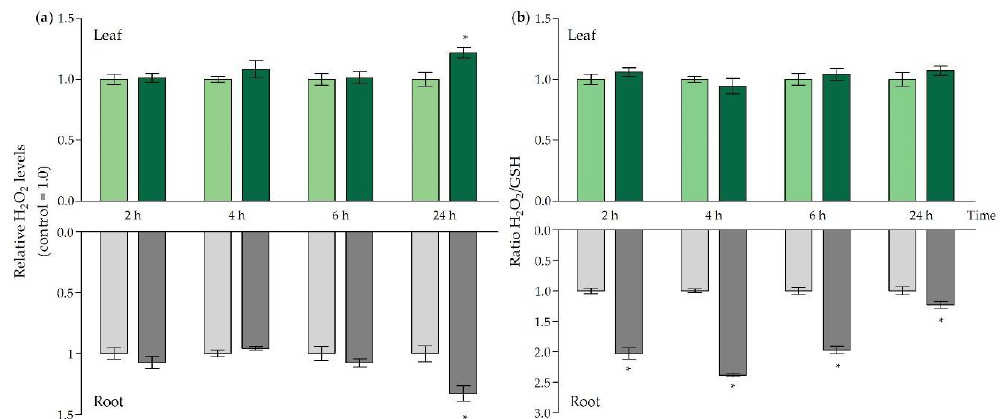
Figure 3. ( a ) Relative hydrogen peroxide (H 2 O 2 ) levels and ( b ) H 2 O 2 / GSH ratios in leaves (green bars) and roots (grey bars) of Arabidopsis thaliana plants grown under control conditions (0 µ M CdSO 4 , light bars) or exposed to 5 µ M CdSO 4 (dark bars) during 2 h, 4 h, 6 h and 24 h after 3 weeks of growth. For each time point, data represent the mean ± S.E. of four biological independent replicates. Significant di ff erences ( t -test: p < 0.05) between control and exposed plants, within each time point, are indicated with an asterisk (*).